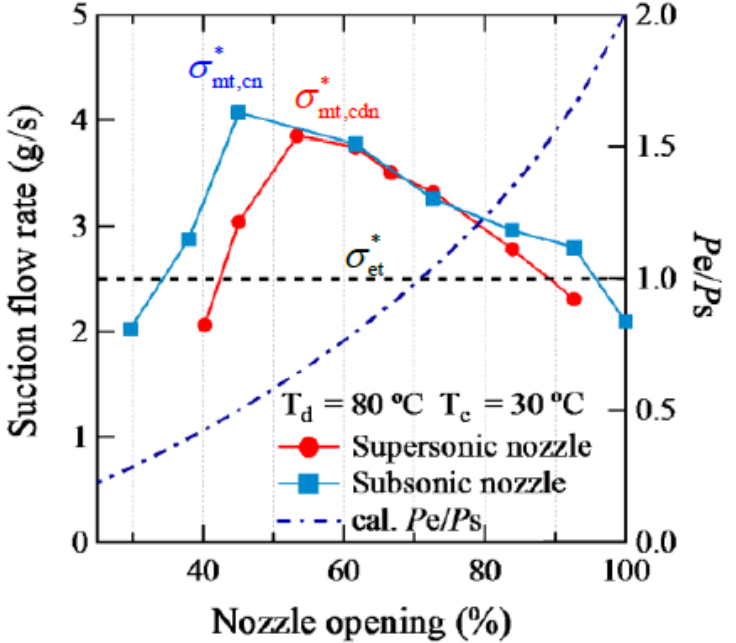
Figure 10. Performance with different nozzle structure at condensing temperature of 30 °C